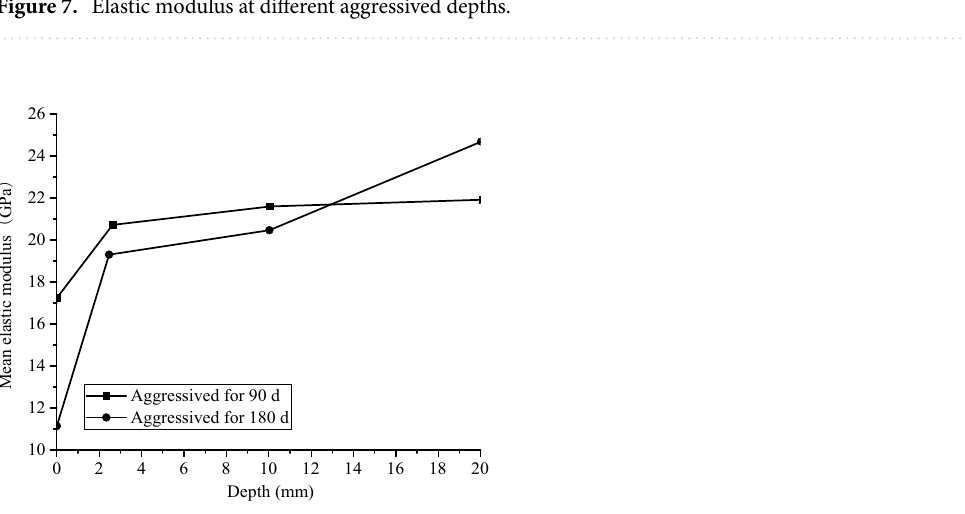
Figure 7. Elastic modulus at different aggressived depths.